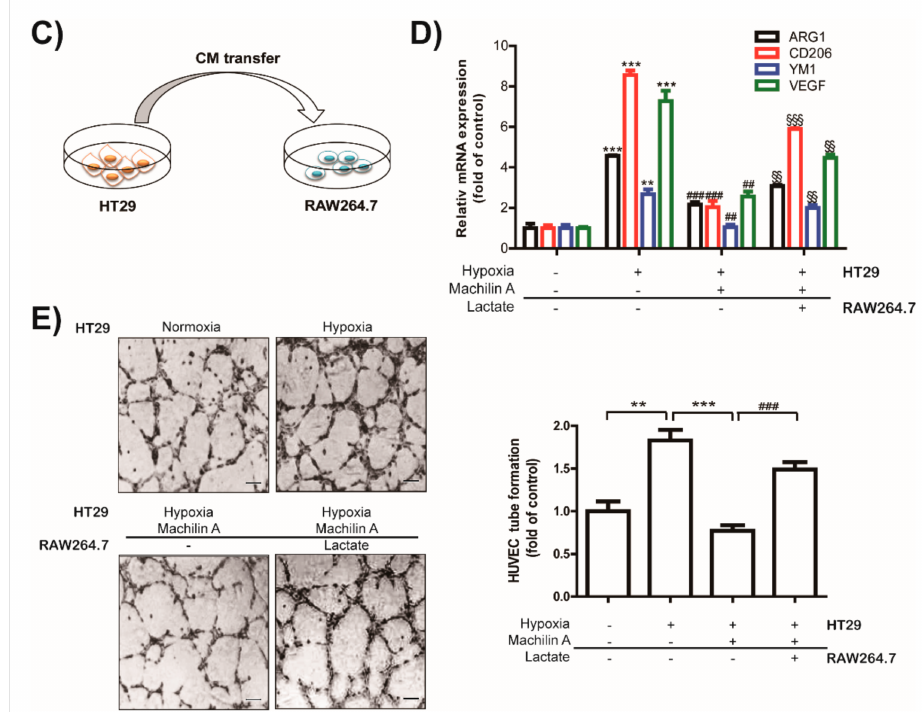
Figure 5. Inhibition of macrophage-mediated neovascularization by suppression of tumor-derived lactic acid in machilin A (MA)-treated cancer cells. ( A ) Tumor specimens were fixed in phosphate-bu ff ered saline (PBS) with 3.7% formalin and then embedded in para ffi n. Tumor tissues were immunostained using a CD31 antibody to detect newly formed vessels in tumor tissues of mice inoculated with LLC cells. Microvessels were manually counted. Data are presented as mean ± SD. Statistic tests were performed using a Student’s t-test. * p < 0.05 compared to the control. ( B ) Tumor tissues were immunostained using an antibody against CD206 M2 phenotype macrophage marker to detect M2 phenotype macrophages, and using an antibody against CD68 macrophage marker to detect infiltrated macrophages in tumor tissues in mice inoculated with LLC cells. Positive spots (brown color) were manually counted. Data are presented as mean ± SD. Statistic tests were performed using a Student’s t-test. *** p < 0.001 compared to the control. ( C ) Scheme about treatment of cancer conditioned media to macrophage. ( D ) HT29 cancer cells were treated with machilin A (30 µ M) and incubated under normoxic or hypoxic conditions. After 48 h of incubation, the conditioned medium (1 mL) harvested from cancer cells was added to RAW264.7 macrophage cells in the presence or absence of lactate (5 mM). The respective expression of Arg-1, YM1, and VEGF mRNAs was determined using qRT-PCR. Data are presented as mean ± SD. Statistic tests were performed using a Student’s t-test. ** p < 0.01 and *** p < 0.001 compared to No. 1. ## p < 0.01 and ### p < 0.001 compared to No. 2. §§ p < 0.01 and §§§ p < 0.001 compared to No. 3. ( E ) Quantitative summary of tube formation was performed by manual quantification of closed tubes in four di ff erent areas, scale bar = 10 µ m. Results of three independent replicates are shown as means ± SD. Statistic tests were performed using a Student’s t-test. ** p < 0.01 compared to No. 1. *** p < 0.001 compared to No. 2. ### p < 0.001 compared to No.